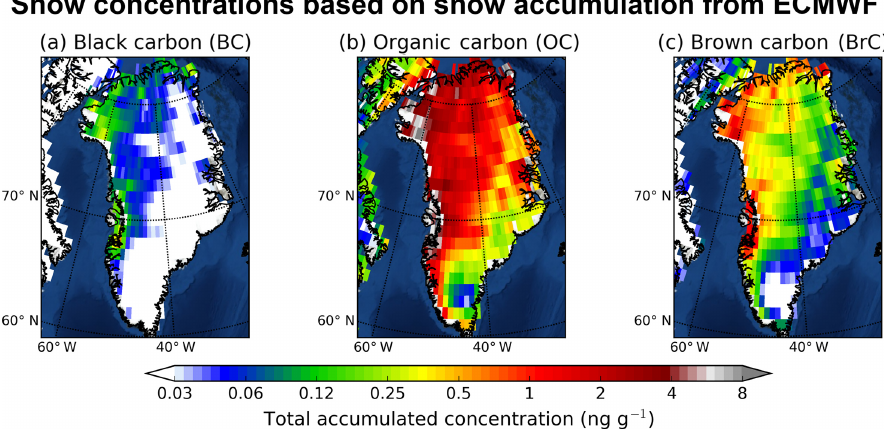
Figure 3. Calculated snow concentrations of (a) BC, (b) OC and (c) BrC over Greenland based on the modeled deposition and the snow precipitation (large-scale and convective) adopted from the operational ECMWF data that were used in our simulation (see Sect.